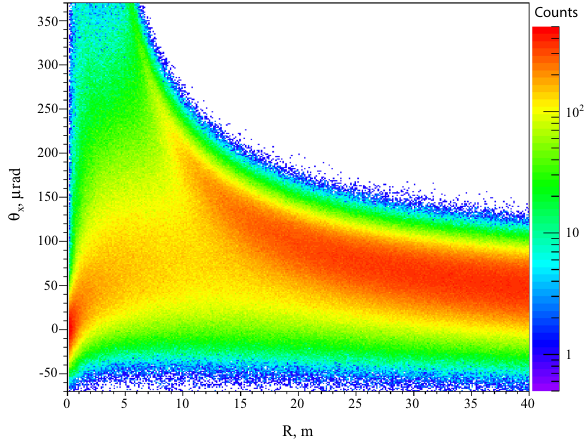
Fig. 5 The dependence of the number of electrons deflected on the angle θ x on the radius of curvature of the crystal for (cid:2) 111 (cid:3) crystal ori- entation with respect to impinging